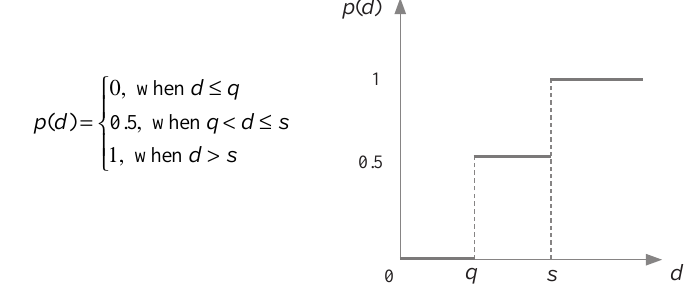
Fig. 4. Level preference function and its